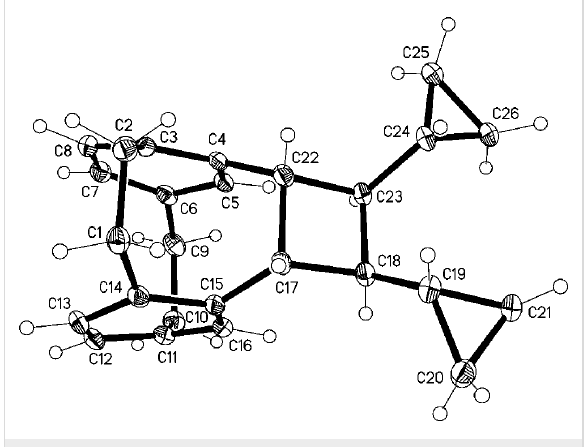
Figure 5: The molecule of compound 24 in the crystal. Ellipsoids correspond to 30% probability